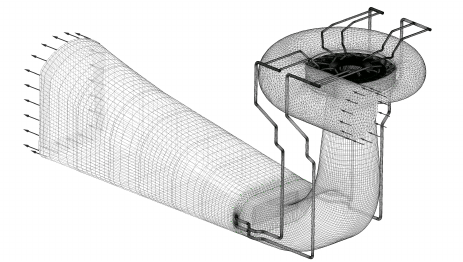
Figure 2. Mesh of the entire flow domains.